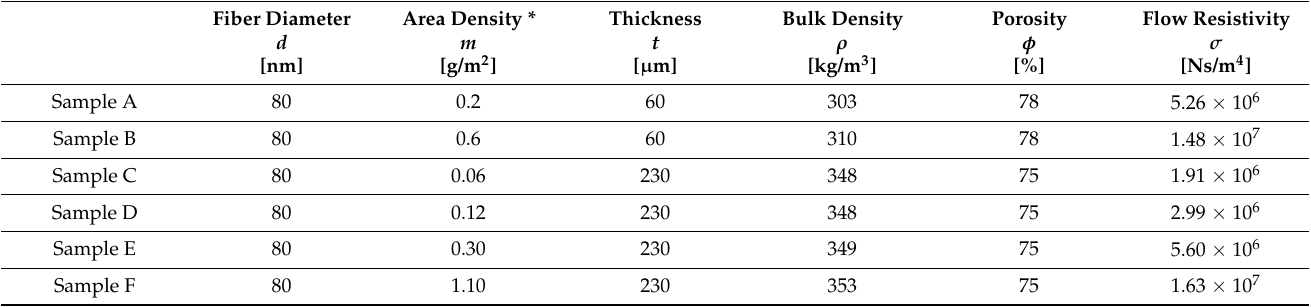
Table 1. Properties the of test